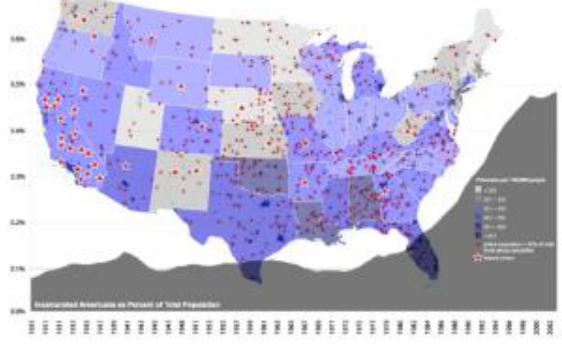
Figure 5. Mapping inmate density